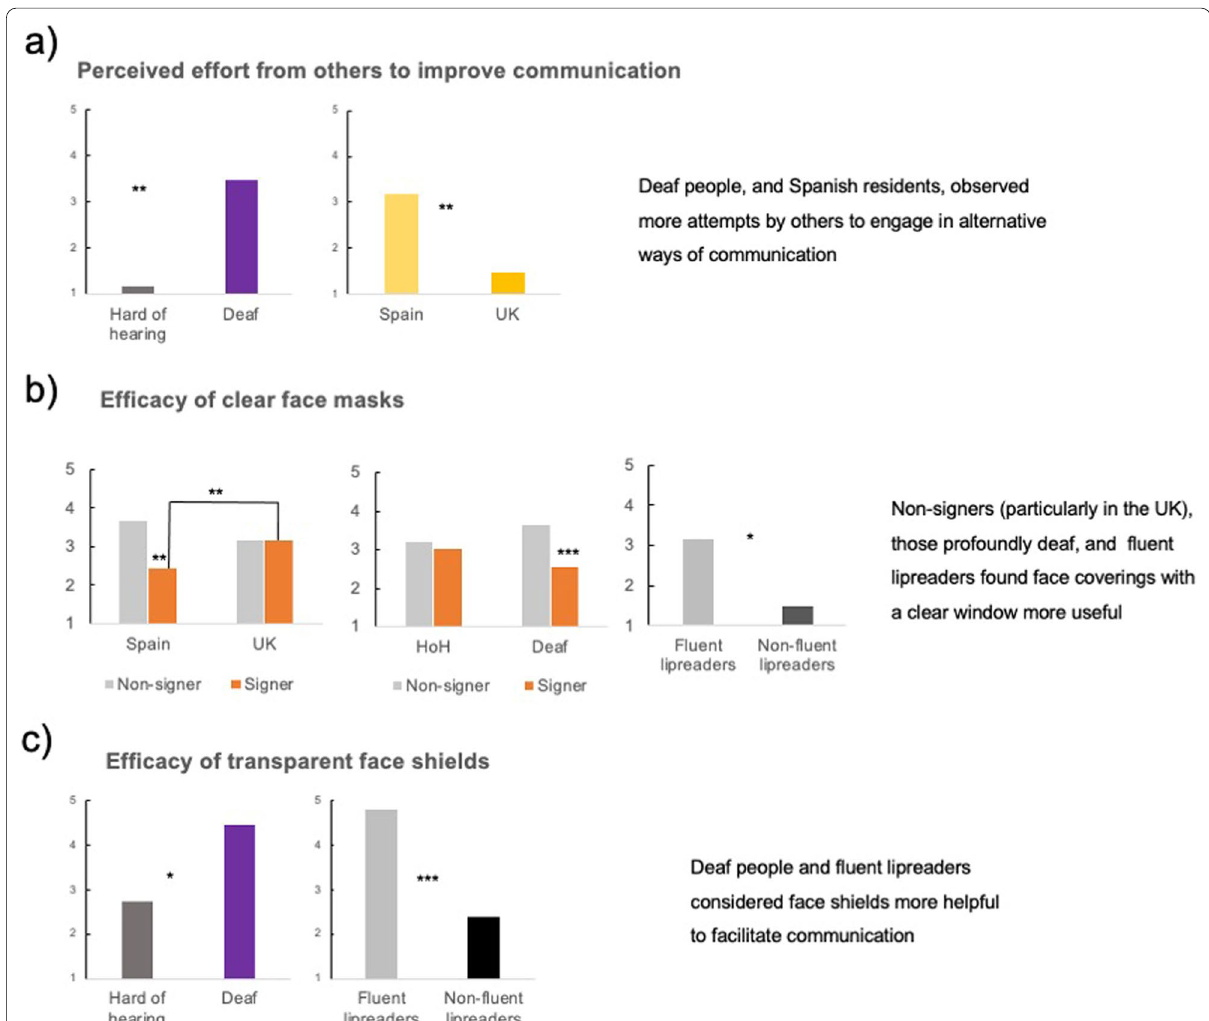
Fig. 5 Overview of significant effects for the three measures on respondent’s opinion on ways to improve communication: other’s efforts to engage in alternative communication such as gesturing or writing ( a ), efficacy of face masks with a clear window ( b ), and efficacy of transparent face shields ( c ). Effects that were significant in the simple slopes analysis are coded as follows, ***